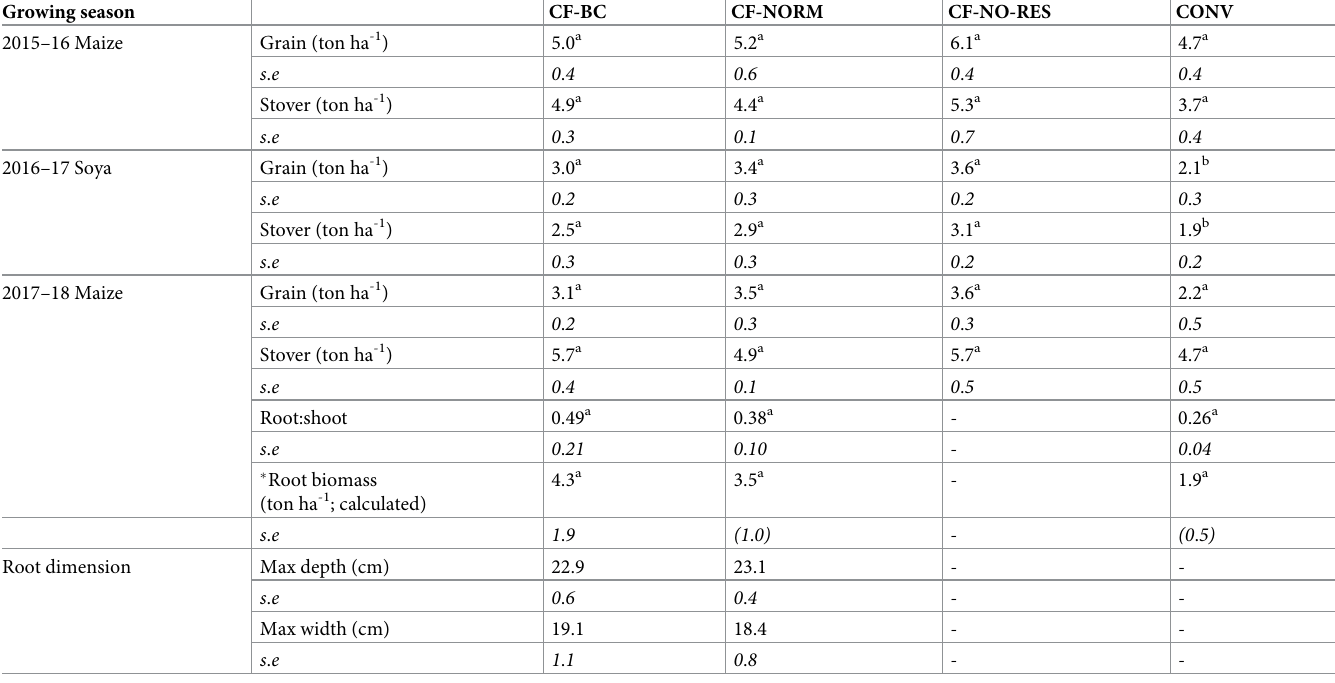
to 20 cm separately, where block was included as random factor. The spatial autocorrelation between repeated measurements in 2016 and 2018 was assumed constant between the different treatment combinations. Two-way ANOVA (treatment 2 levels and in vs. out 2 levels) was used to assess the difference in POM, POC, PON and C:N ratio of POM between CF-NORM and CF-NO-RES inside and outside basins in each depth independently. Differences between variables retained in the parsimonious models were analyzed by Tukey test at 0.05 significance. Linear regression was used to assess the relationship between HWEC and potential N mineral- ization